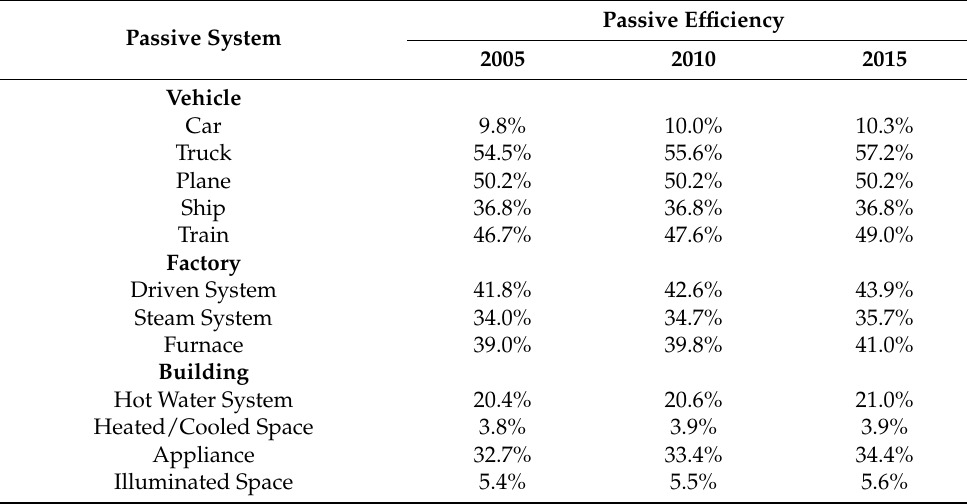
Table A5. Passive efficiency of passive systems.